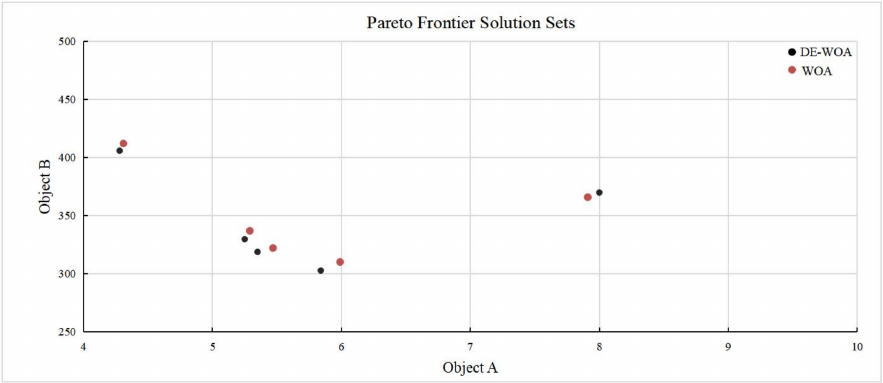
Figure 4. Set of Pareto front solutions under both algorithms.